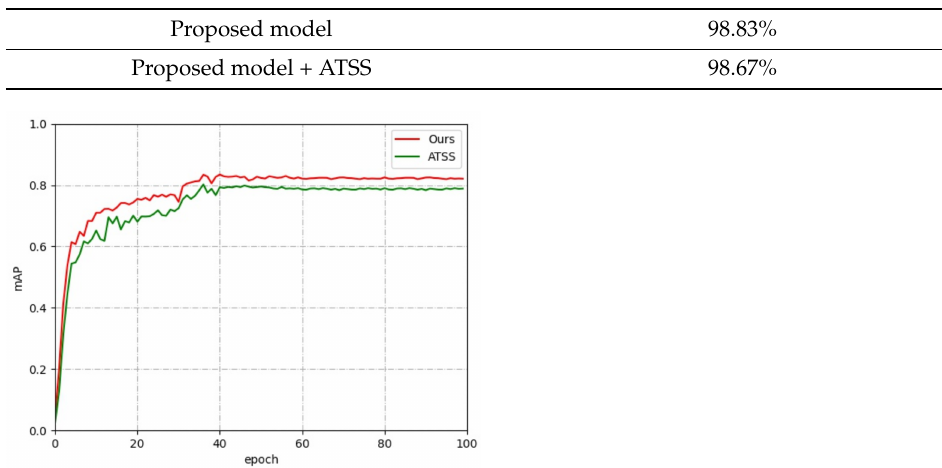
Table 5. Comparison of mAP values of the proposed matching strategy with ATSS on the multi-scene electronic component dataset.